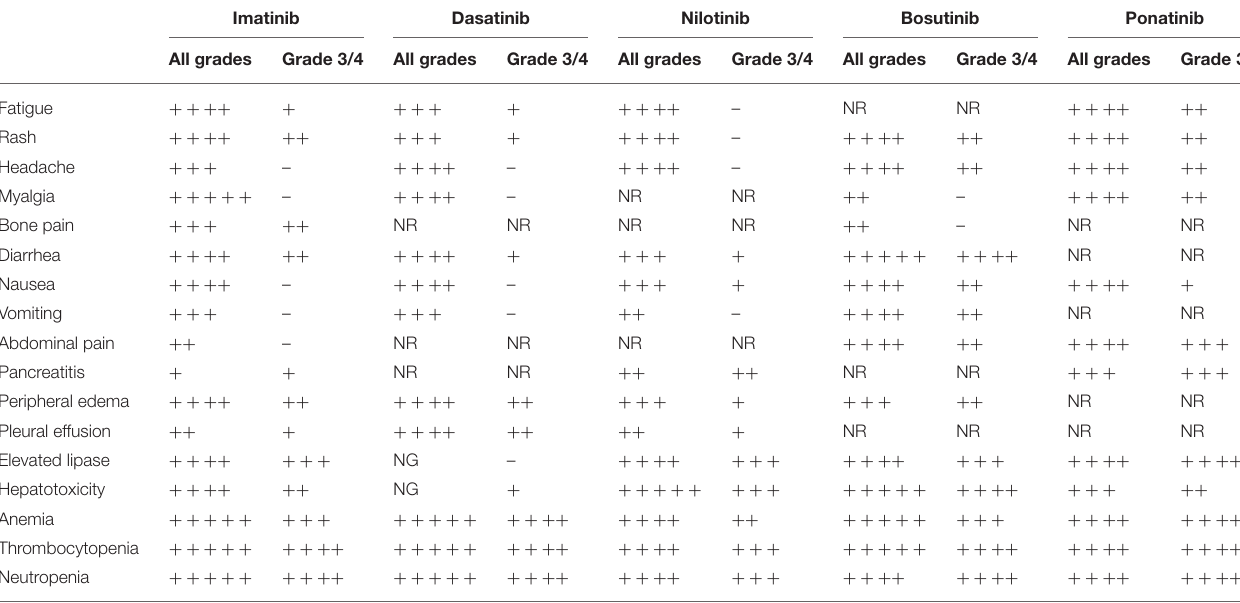
reported; NG, data not